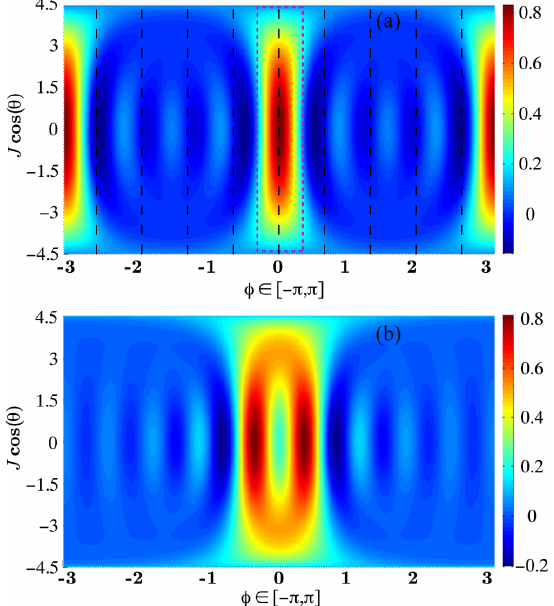
FIG. 10. An equal-area plot of the Wigner function of an equal mixture of two eigenstates after the QFT, D ¼ 10 . (a) The worst permutation; cf. Fig. 8(c). The dashed vertical lines correspond to the locations of the peaks of the D -transformed eigenstates. The dotted box around the peak at (cid:9) ¼ 0 corresponds to the bulk of the Wigner function for this state. (b) The conjectured general optimal permutation; cf. Fig. 8(b).